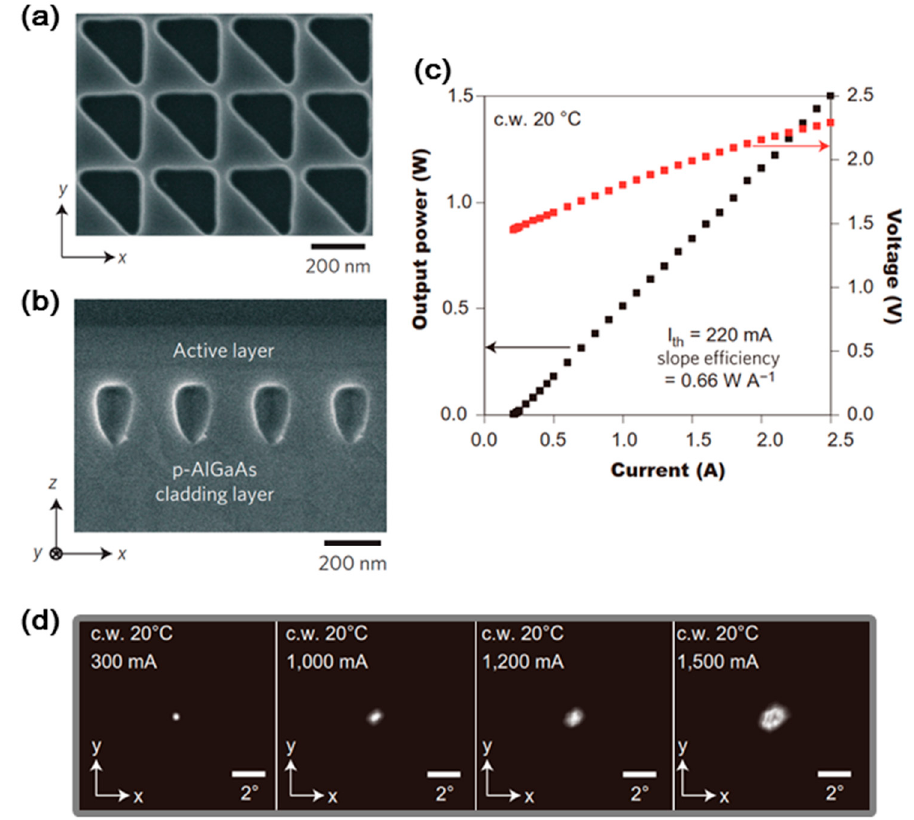
Figure 10. ( a ) Top-view SEM image of square-lattice photonic crystals with right-angled triangular lattice points. ( b ) Cross-sectional SEM image after air-hole-retained crystalline regrowth. ( c ) I–L characteristics and I–V characteristics during continuous wave (CW) operation at room temperature. ( d ) FFPs for different injection current levels. Reprinted by permission from Springer Nature, Nature Photonics [13], 2014.